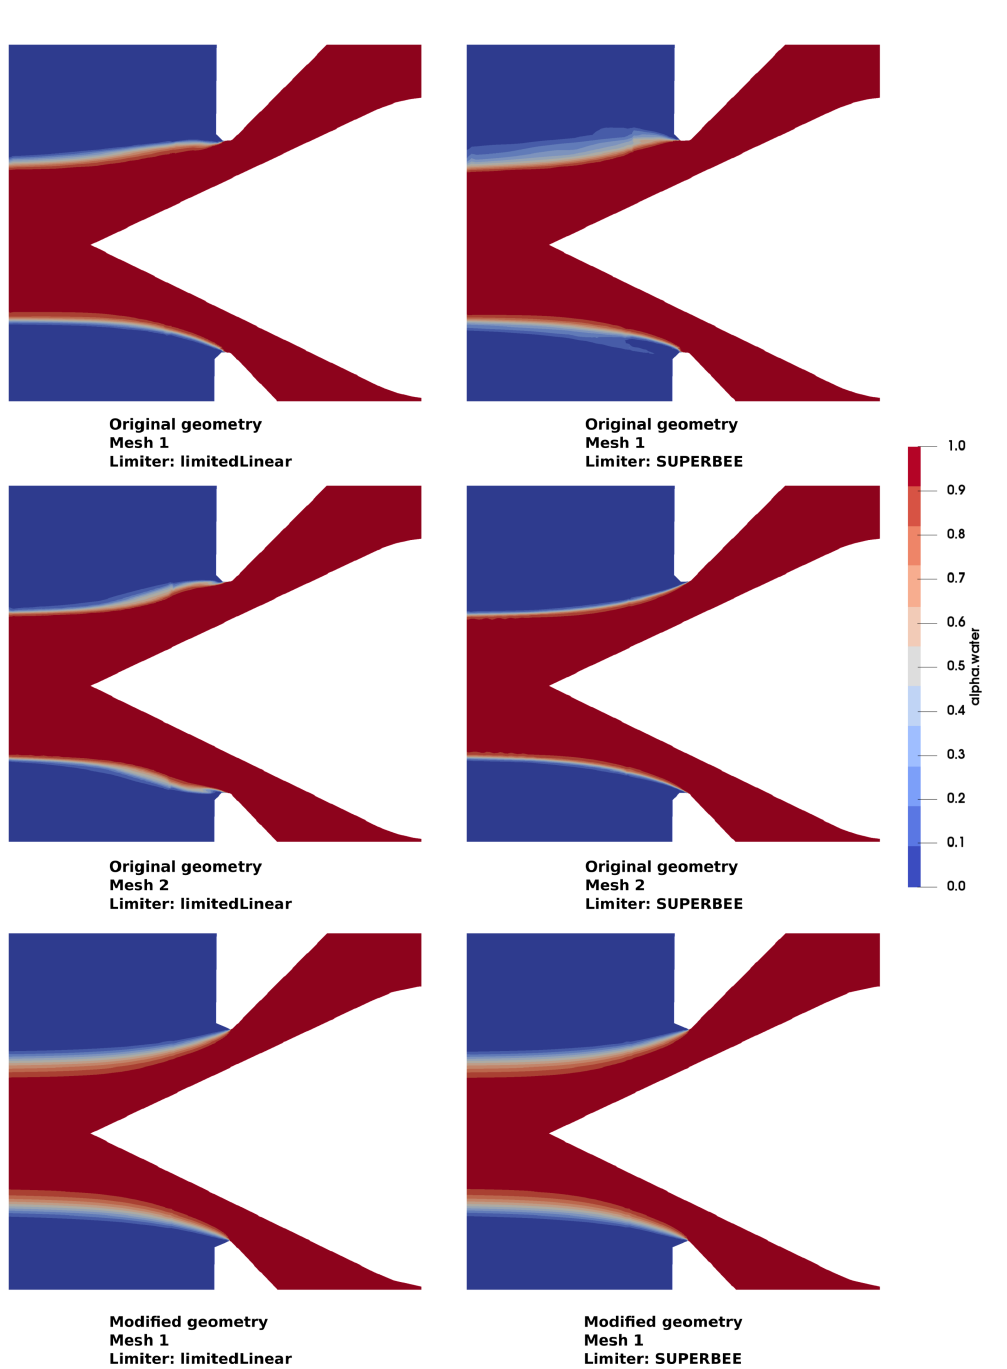
Figure 8. Contour of the liquid volume fraction ( alpha . water ) in the mid-plane aligns with the jet axis. Simulations for a needle stroke of